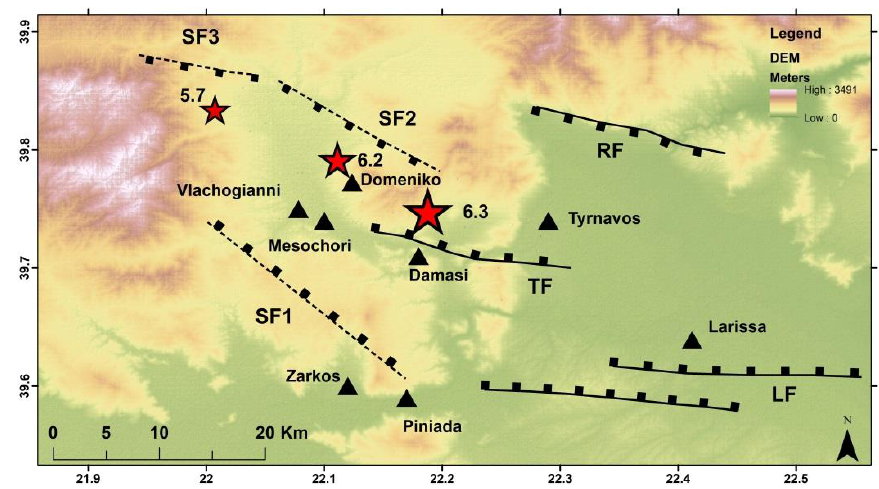
Figure 23. Inferred surface projections of the blind seismic faults that activated with the 3 (SF1, Zarkos Fault), 4 (SF2, Domeniko Fault) and 12 March 2021 (SF3, Kalivia Fault) earthquakes according to our interpretation of the combined seismic and geodetic analysis. Strikes and dip angles of SF1, SF2, SF3 were adopted as the respective averages of strikes and dip angles calculated from the different methods (Tables 4 and 5): 314°/41° for SF1, 123°/44° for SF2, 112°/42° for SF3. Positions of the three faults were adopted by taking into account the fault models, resulted from the inversion of teleseismic P waveforms and of InSAR data, as well as the respective relocated focal depth (Table 3) and the average dip angle for each fault. Lengths of about 23, 17 and 11 km were calculated for SF1, SF2 and SF3, respectively, by taking into account rupture lengths determined from our seismic and geodetic fault models (Figures 8, 11, 14 and 22) and a worldwide empirical relationship between subsurface rupture length and magnitude found for normal earthquakes [46]. Epicenters (stars) and magnitudes of the strong earthquakes of 3, 4 and 12 March 2021, as well as of the main faults (black lines) in the Thessaly area, as in Figure 1.